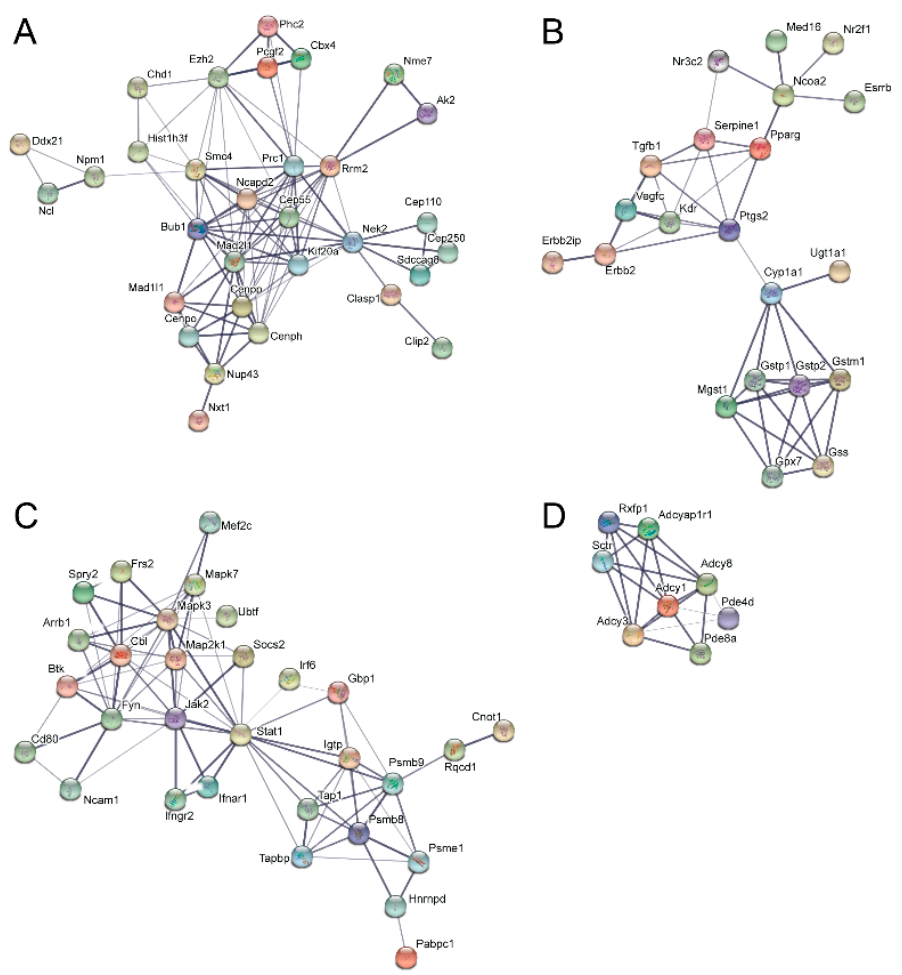
Figure 5. Identification of molecular interaction networks enriched for genes whose expression is altered during the transition from day 0 to day 1 in emerin-null myogenic differentiation. Differentially expressed genes present in only differentiating emerin-null progenitors during the transition from day 0 to day 1 in emerin-null cells were analyzed using STRING to identify interaction networks implicated in their impaired differentiation. The most enriched networks are shown and represent ( A ) cell cycle, ( B ) glutathione metabolism, ( C ) JAK-STAT signaling, and ( D ) G-protein and cAMP signaling.